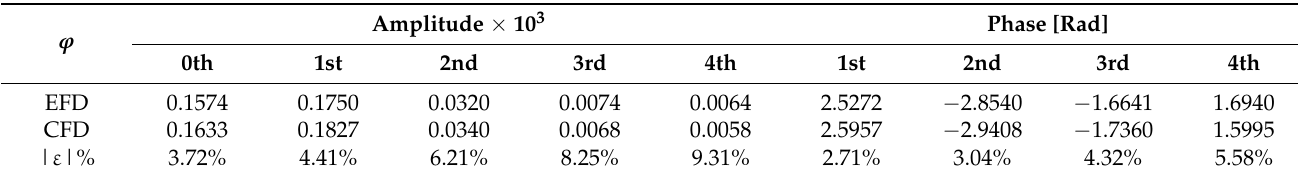
Table 27. Harmonic amplitudes and phases of roll for the FRxz ϕθ following waves scenario.